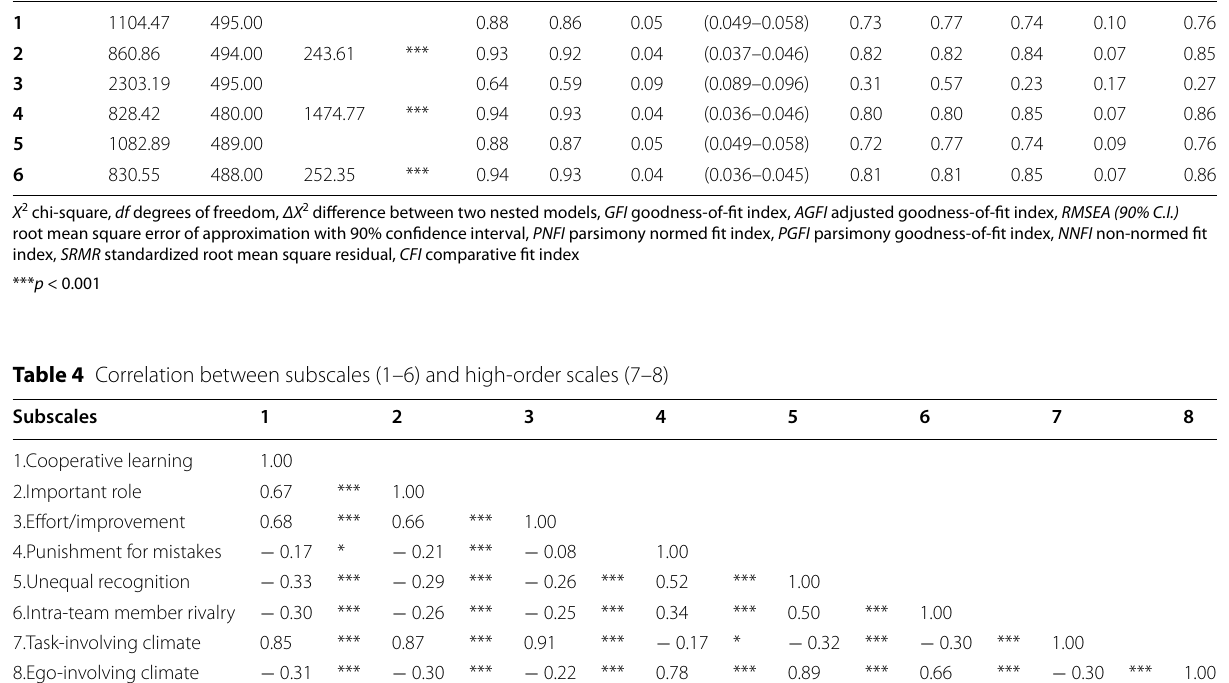
X 2 chi-square, df degrees of freedom, ΔX 2 difference between two nested models, GFI goodness-of-fit index, AGFI adjusted goodness-of-fit index, RMSEA (90% C.I.) root mean square error of approximation with 90% confidence interval, PNFI parsimony normed fit index, PGFI parsimony goodness-of-fit index, NNFI non-normed fit